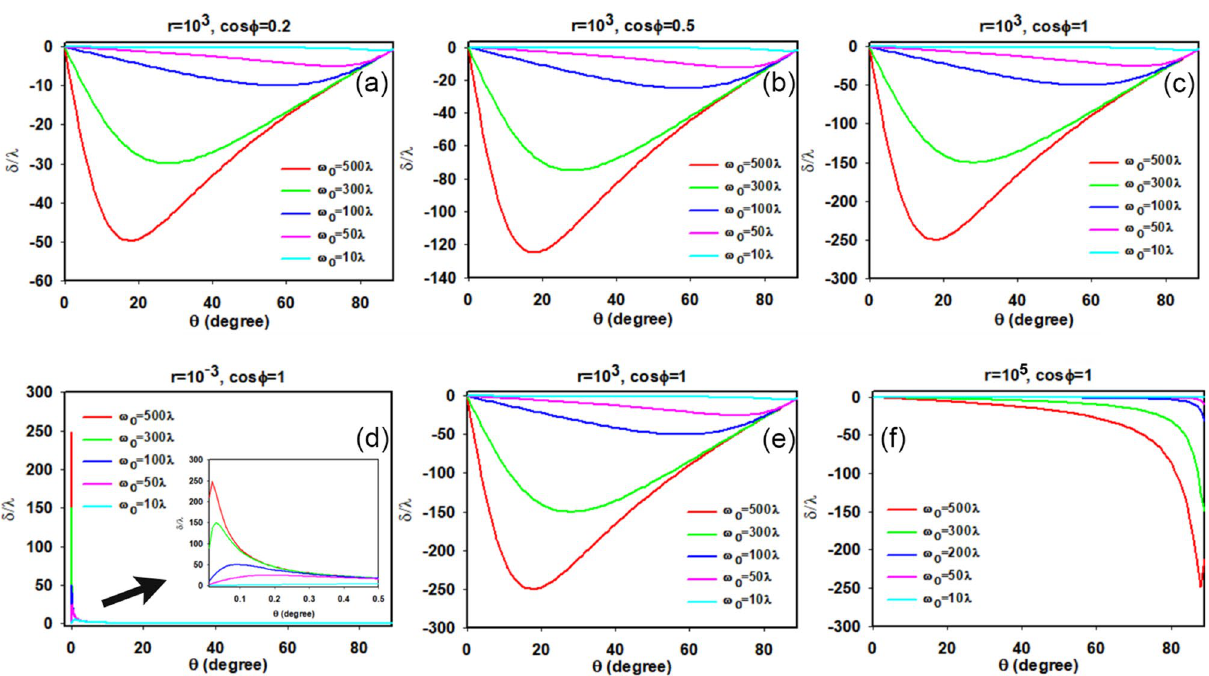
Figure 3. Dependence of the transverse shifts on ω 0 at certain r and different cos ϕ (a–c) ; dependence of the transverse shifts on ω 0 at certain cos ϕ and different r (d–f)